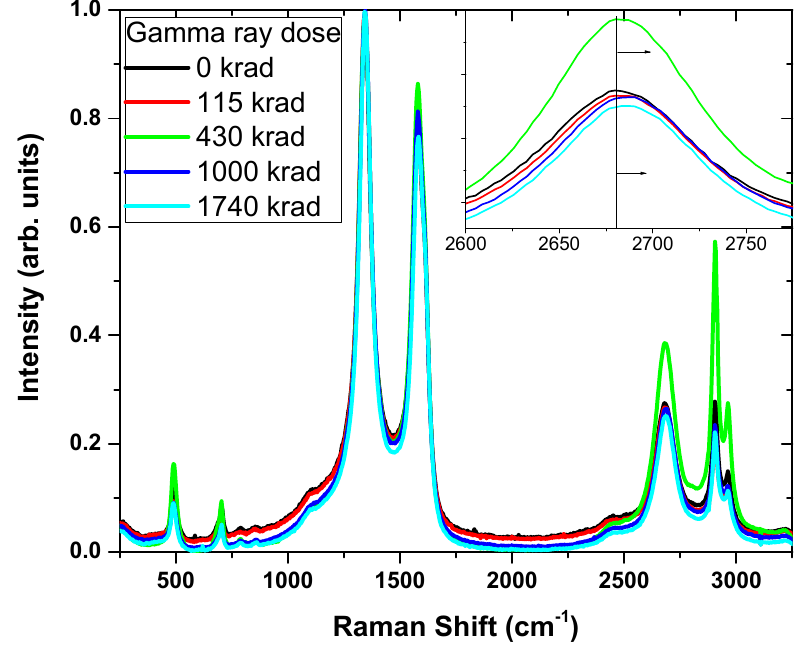
Figure 9. Raman spectroscopy of 10 wt.% MWCNT / Silicone rubber with gamma radiation dose. The inset is a magnification of the sensitive 2D band shift.